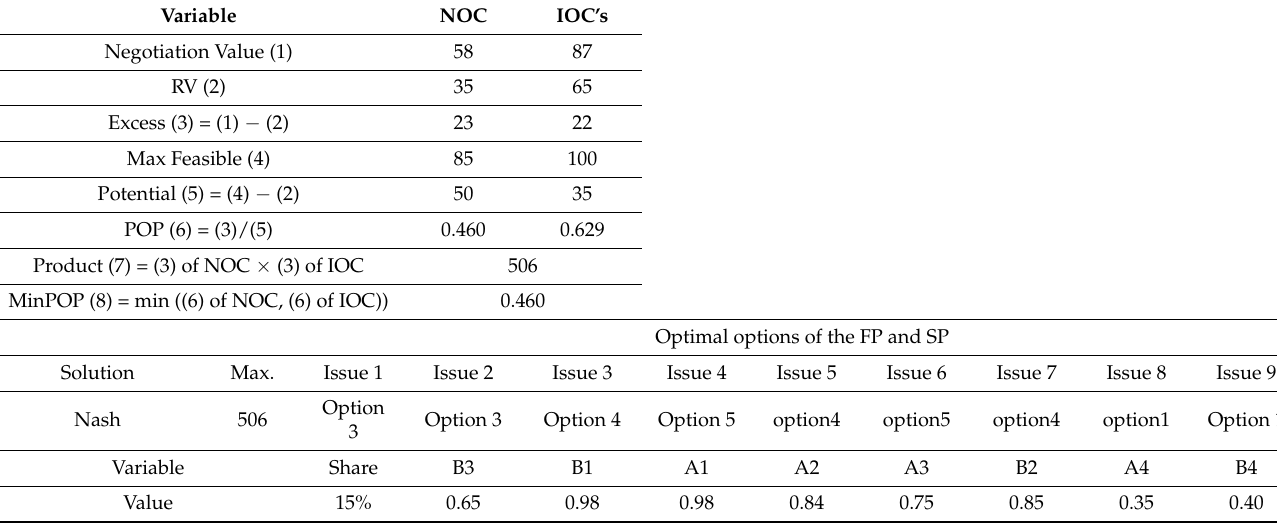
Table 8. Solver output of Nash solution of the FP and SP.